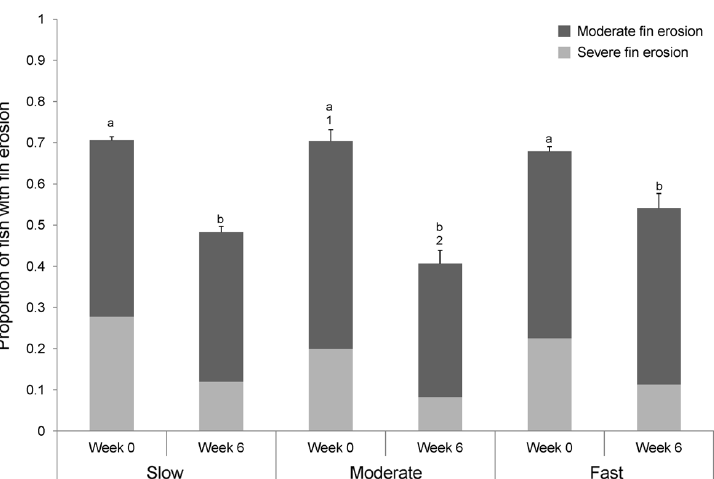
Fig. 3. Mean of cumulated fin erosions at start and end of experiment in fish kept at slow (0.2 body length [BL] s −1 ), moderate (0.8 BL s −1 ) and fast (1.5 BL s −1 ) water current velocities. The columns are separated into fish with moderate fin erosion and fish with severe fin erosion. Error bars show SE of cumulated fin erosions. Lowercase letters denote significant differences between current velocities, and numbers denote significant differences between weeks (p <